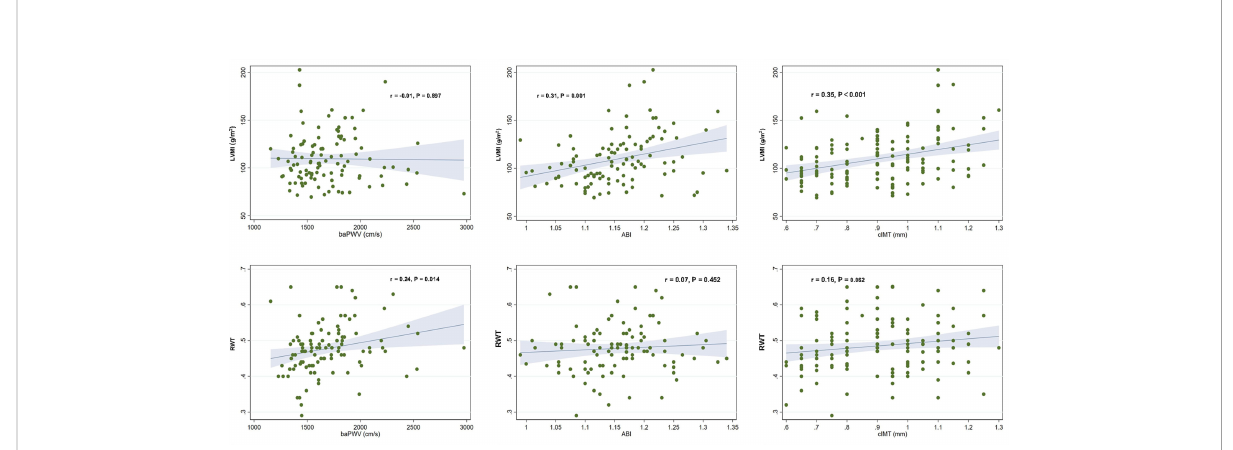
FIGURE 1 Correlation plots showing the associations of vascular parameters with left ventricular mass index and relative wall thickness. Each dot indicates an individual patient ’ s data. The linear regression line (blue line) and 95% con fi dence interval (shaded area) are depicted. LVMI, left ventricular mass index; baPWV, brachial – ankle pulse wave velocity; ABI, ankle – brachial index; cIMT, carotid artery intima-media thickness; RWT, relative wall thickness.